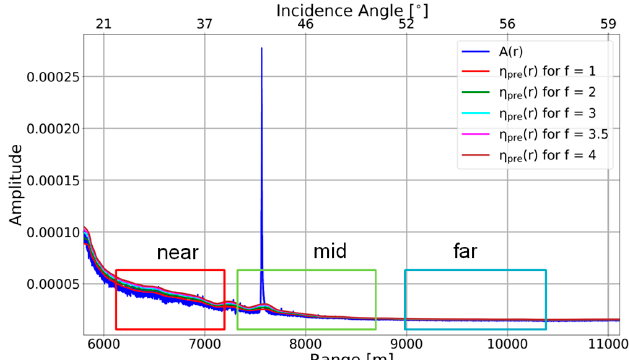
Figure 8. Average amplitude range profile with range dependent pre-detection thresholds. A high target peak ( = ship) is present at a range of approximately 7500 m. The e ff ectiveness of the MAD based pre-detection is evaluated in three di ff erent zones; near (red), mid (green) and far range (blue). Details are shown in Figure 9.